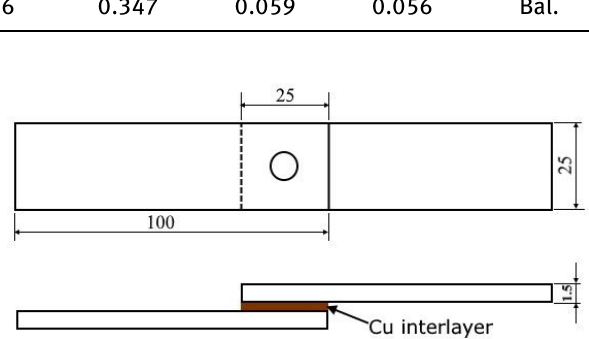
and 100 mm, respectively with an overlap area of 25